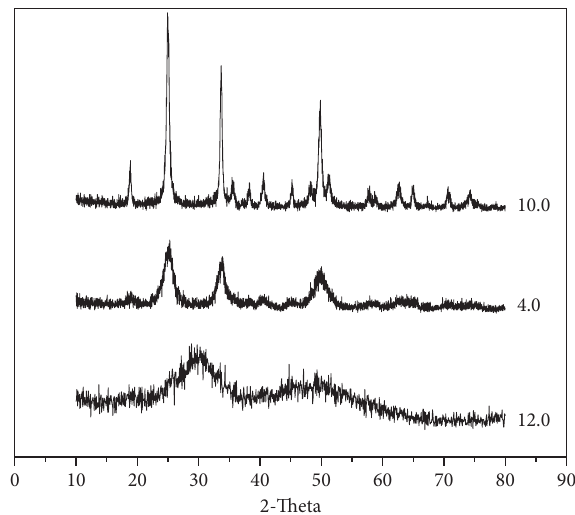
Figure 5: XRD patterns of samples produced through ultrasonic irradiation at different pH end values.